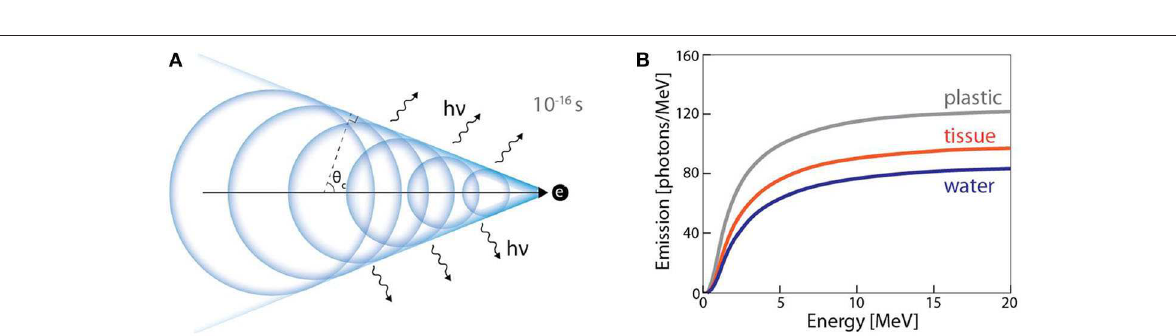
FIGURE 10 | Scintillating sheet imaged dose rates from a proton pencil beam scanning system with modulated beam parameters in the treatment plans. (A) Maximum dose rate distribution with 10mm spot-spacing. (B) Cumulative dose rate histogram for varying minimum spot weight of a treated layer. Data adapted from Rahman et al. [35].